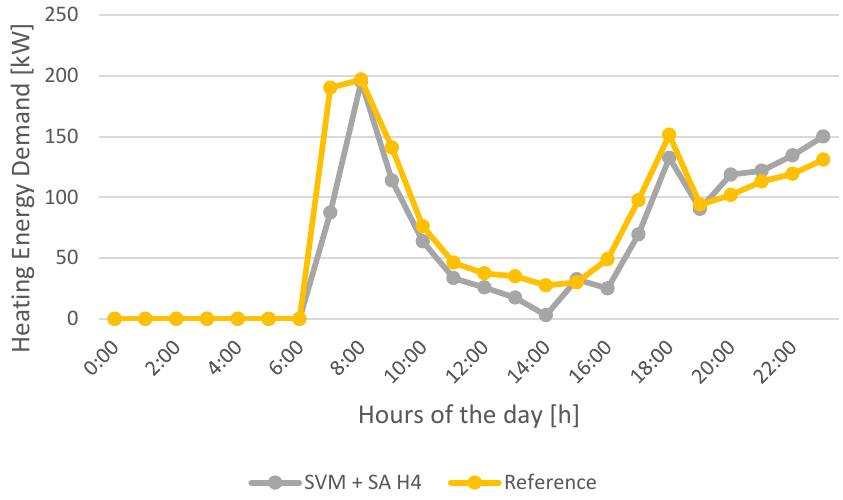
Figure 20. Load profile comparison between SVM + SA model H4 and reference for the heating period.